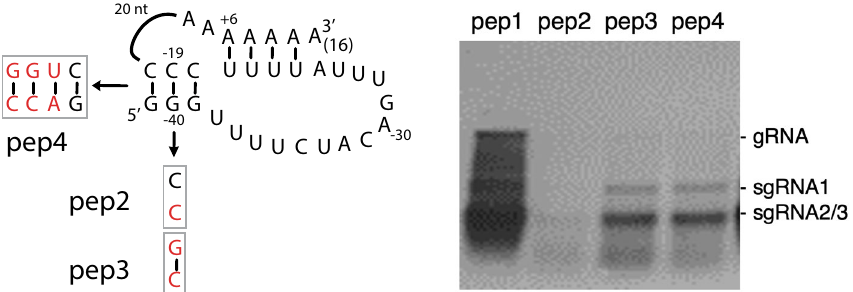
Figure 4. Role of S1 length and stability in replication. For the sake of clarity hp1 is not depicted. Northern blot showing the accumulation of PepMV gRNA and sgRNAs in N. benthamiana protoplasts.